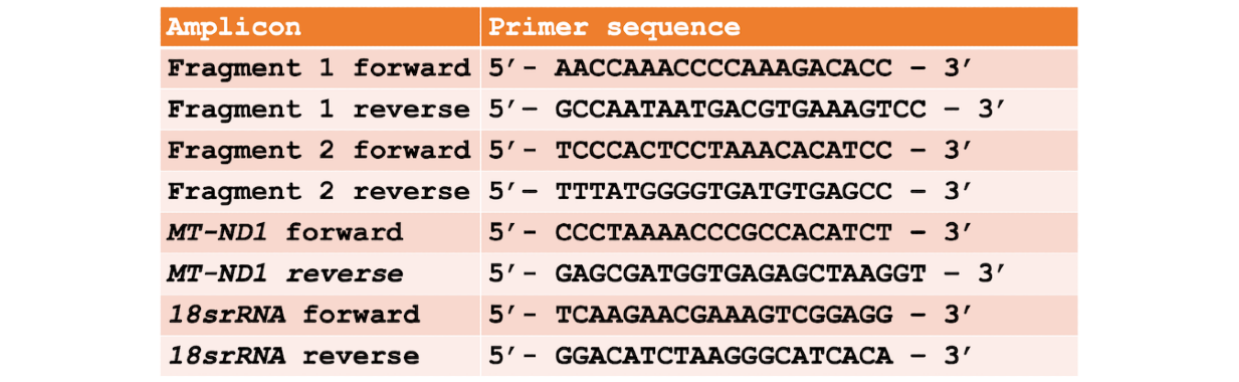
Figure 4. Sequence of primers that will be used to amplify cardiomyocyte (CMC) mitochondrial DNA fragment 1 (9289 bp in length) and fragment 2 (7626 bp in length). 18srRNA: 18S ribosomal RNA; MT-ND1: mitochondrial NADH-ubiquinone oxidoreductase chain